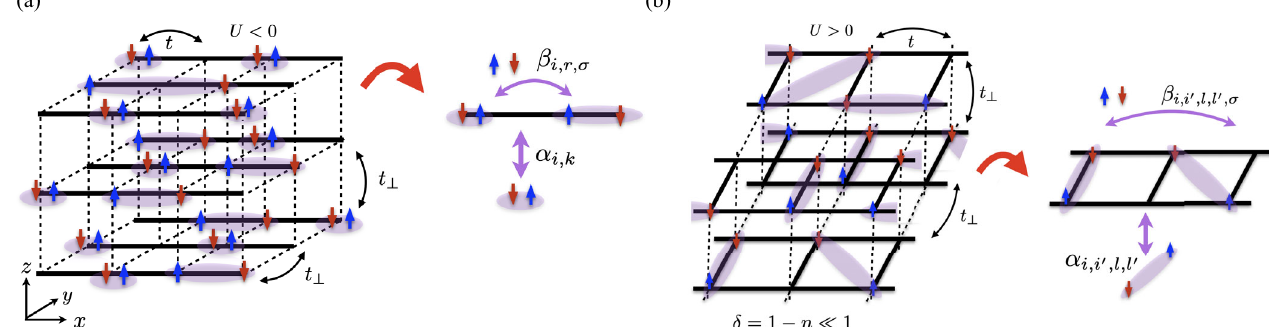
FIG. 1. Overview of MPS þ MF for fermions. A 3D array composed of weakly coupled 1D subunits is mapped onto a self-consistent 1D problem with mean-field amplitudes α and β . (a) Array of negative- U Hubbard chains, with on-site attraction U , tunneling t i;k i;r; σ along the chain, and interchain tunneling t ⊥ . (b) Array of repulsive- U -doped Hubbard ladders. Doping levels are δ , n.n. tunneling (nearest-neighbor tunneling) inside the ladders is t and t ⊥ in between